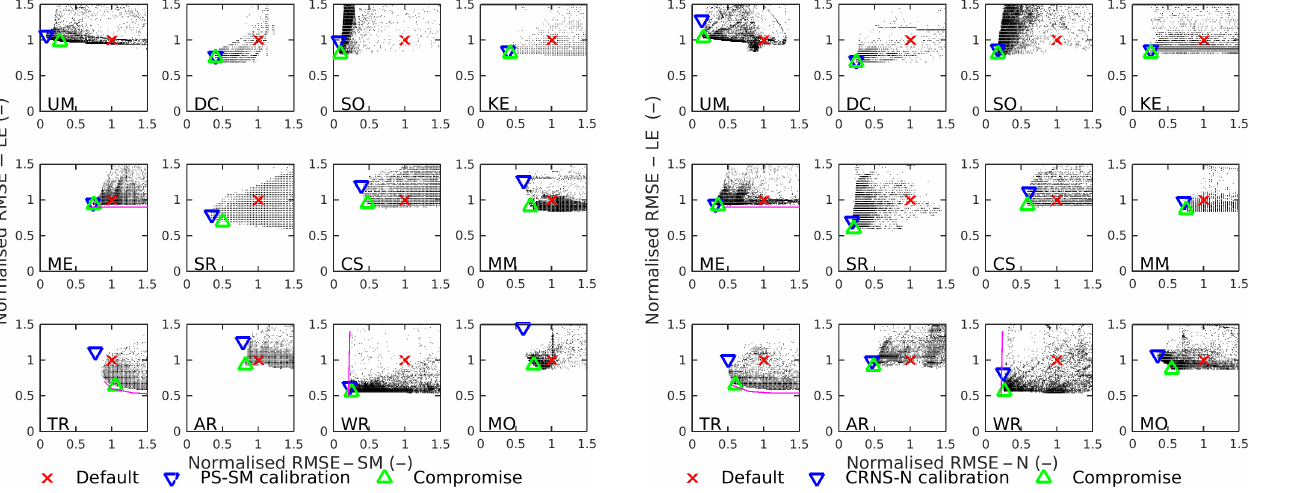
Figure 9. All runs from the two-objective calibrations against PS soil moisture and daytime hourly latent heat flux (LE) at each site. The default run, the PS-SM single-objective calibrated run, and compromise solution runs are shown on top. All values were nor- malized to the values of the default run. The plots were zoomed in to the area of 0 to 1.5 times the default values.